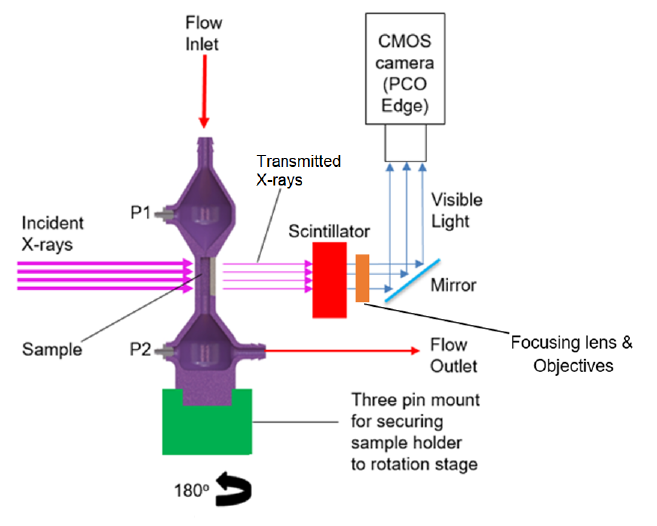
Figure 1. Imaging set-up for fast synchrotron imaging at Diamond Light Source beamline I13-2. Aerosol is flowed continuously through the 3D printed sample holder (purple) from top to bottom whilst it is rotated through 180° for